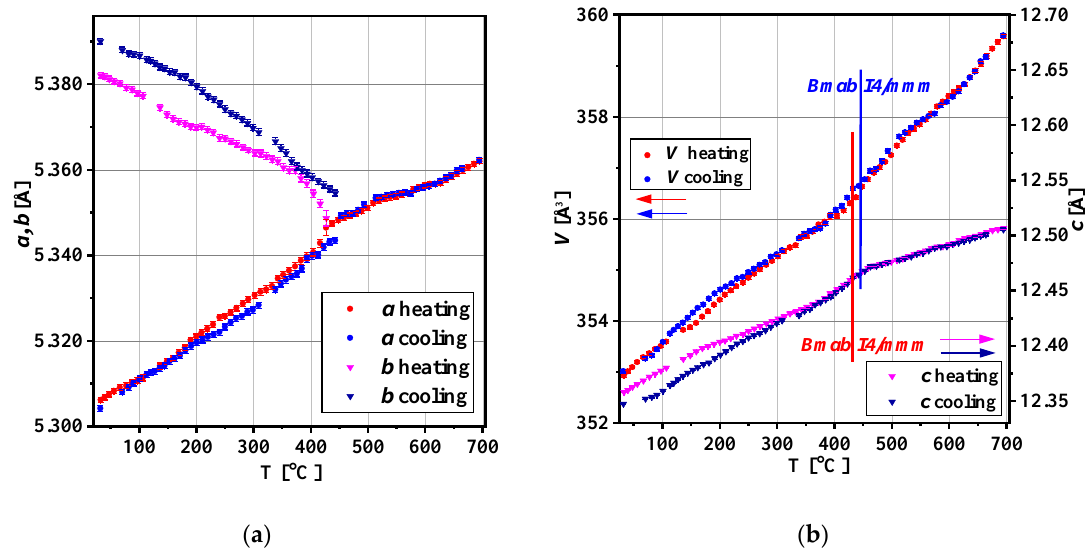
Figure 4. Changes in the a and b lattice parameters upon heating/cooling in the He flow ( a ); the unit cell volume and the c parameter change ( b ) for the NCNCO02 sample. Parameters of the tetragonal structure are given in an unconventional F4/mmm sp.gr. for the direct comparison with those of a Bmab sp.gr. Table 4. Results of the in-situ XRD study of the NCNCO00-NCNCO04 samples: unit cell parameters (UCP) and unit cell volume (UCV) (collected at room temperature), temperatures of the phase tran- sition ( T pt ), and calculated values of the volumetric thermal expansion coefficient (VTEC).